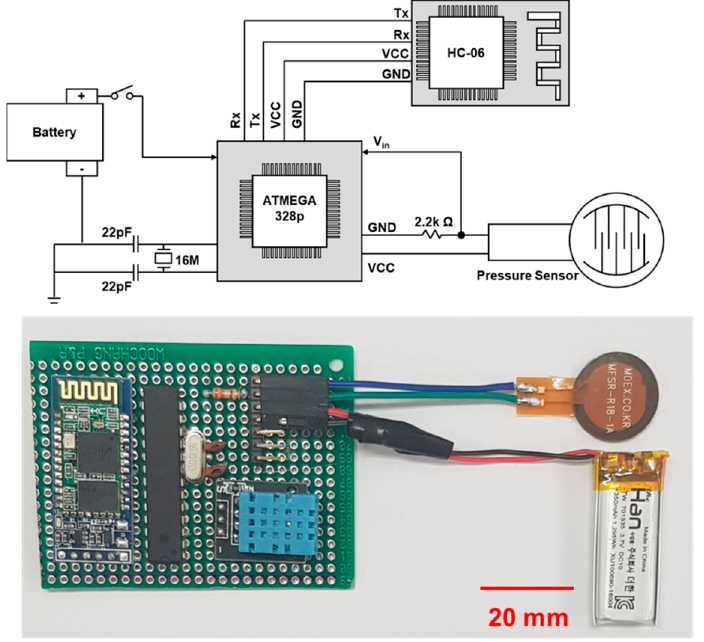
Figure 4. Scheme (top) and image (bottom) of the electronic platform. Figure 4. Scheme ( top ) and image ( bottom ) of the electronic